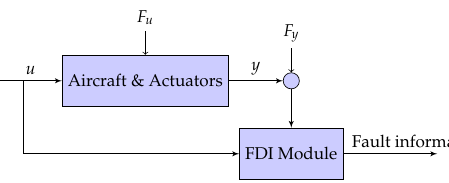
Figure 1. Representation of the system affected by actuator and sensor